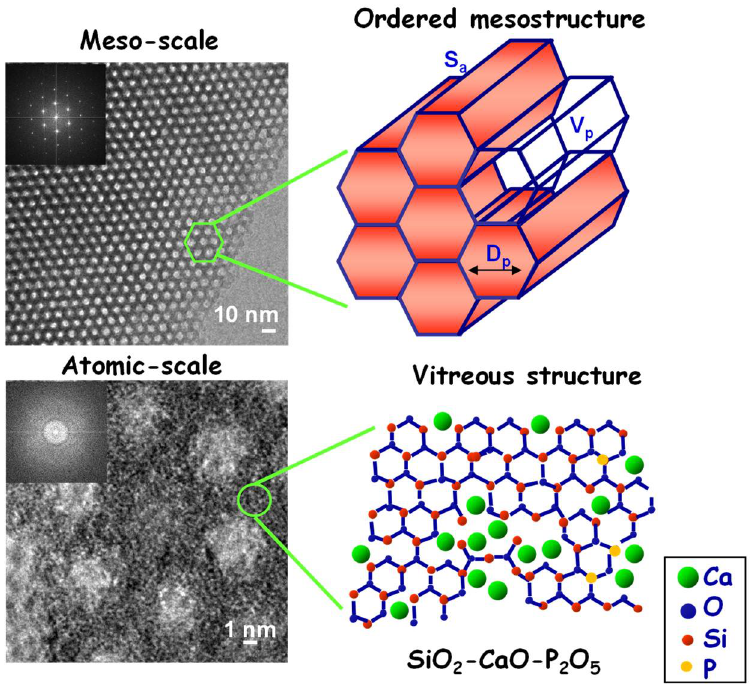
Figure 1. Intrinsic characteristics of MBGs. DP: pore diameter; Sa: surface area; VP: pore volume. Reprinted (adapted) with permission from the reference [39]. Copyright 2010 Elsevier.